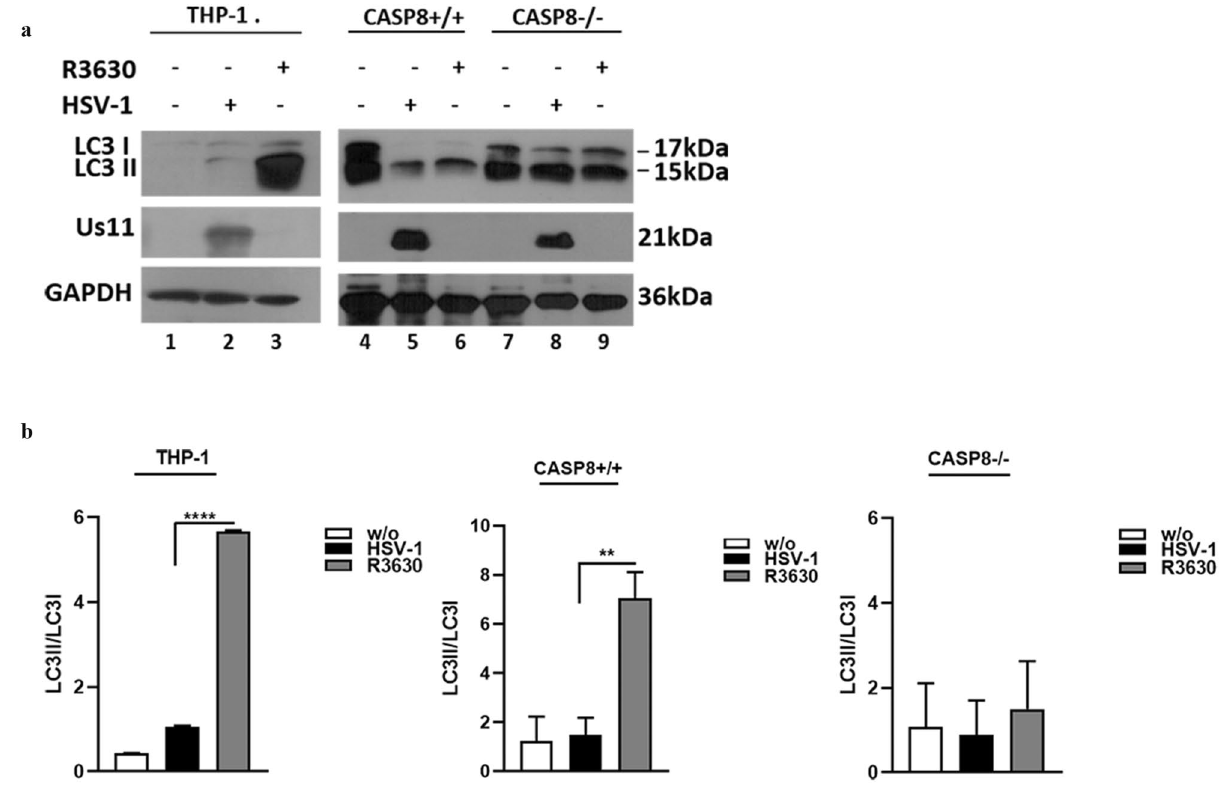
Figure 6. LC3 lipidation in HSV-1 infected cells. ( a ) THP-1 cells were infected at 50 MOI with HSV-1 and R3630 and collected 48 h p.i. CASP8 +/+ and CASP8 -/- cells were infected at 10 MOI with HSV-1 and R3630 and collected 24 h p.i. Cells were then lysed and the LC3 expression was detected by immunoblotting. GAPDH was used as a loading control. ( b ) The LC3-II/LC3-I ratios of HSV-1 and R3630 infected samples were normalized to the LC3-II/LC3-I ratio of control-uninfected cells and graphically represented with GraphPad Prism 6 software. Statistical significance was tested using one-way ANOVA (** p < 0.01, **** p <